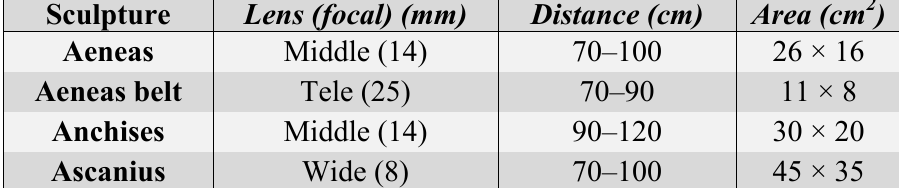
Table 1. Details of the data acquisition